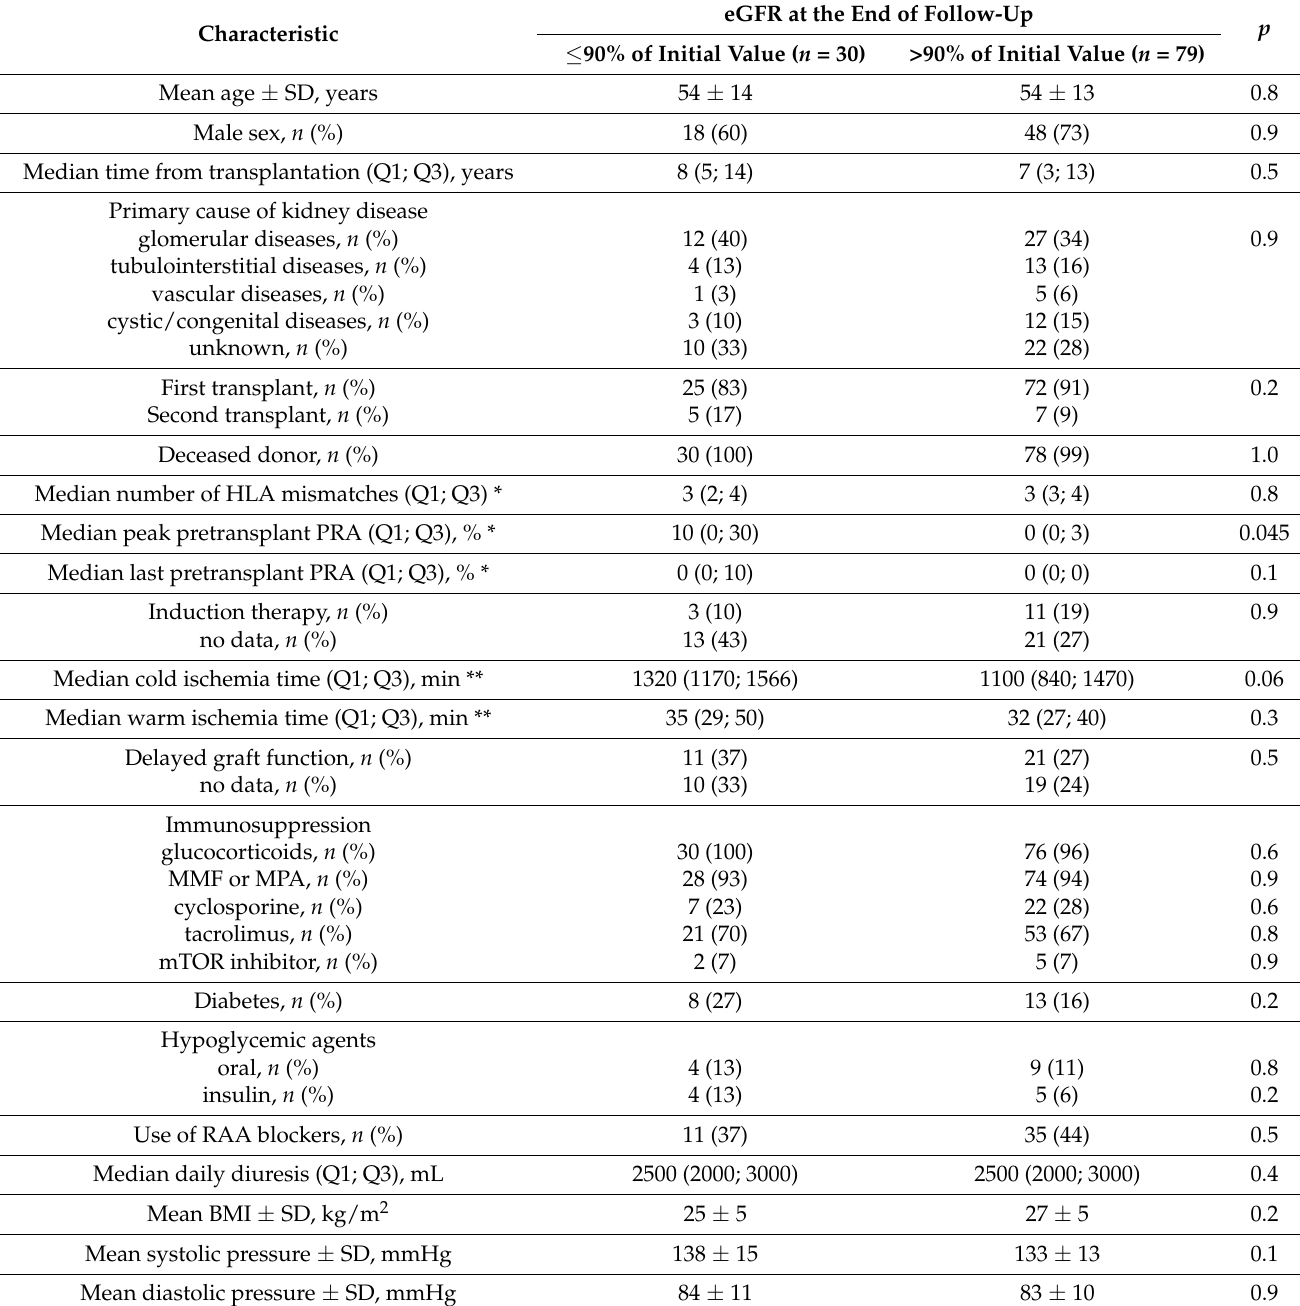
eGFR at the End of